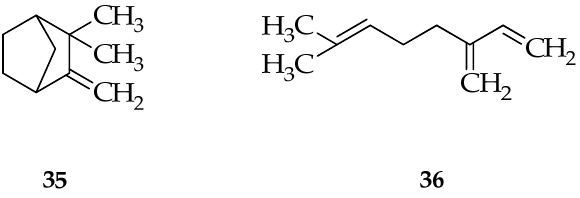
Figure 9. Structure of compounds of isolated red betel leaf oil. ( 35 ) Camphene and ( 36 ) Myrcene [13].